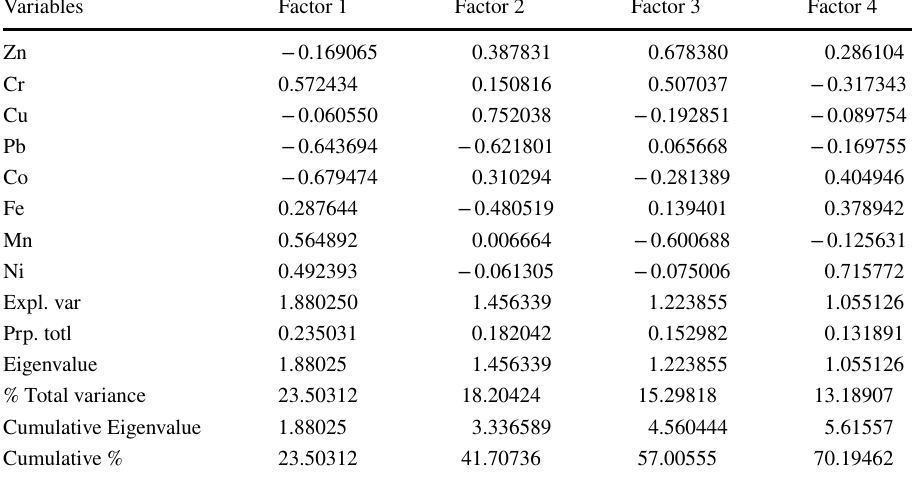
the quaternary formation groundwater samples (varimax